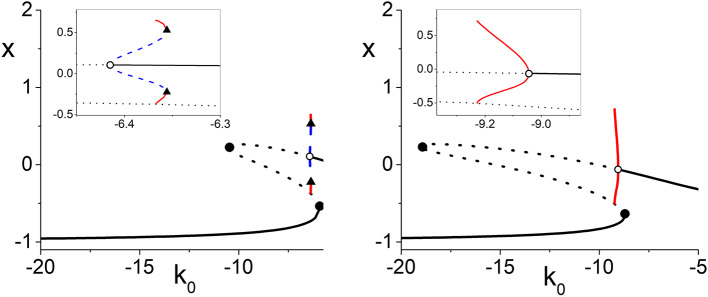
One-dimensional bifurcation diagrams showing x = Re(z) vs. k0 illustrating subcritical (left) and supercritical (right) Hopf bifurcations (open circles). The insets are magnifications. These diagrams correspond to paths along the black lines in the top left panel of Figure 7. Here, black solid (dotted) lines are stable (unstable) equilibria, red (dotted blue) lines indicate stable (unstable) limit cycles, solid circles are saddle-node bifurcations, and triangles are saddle-node-of-periodic-orbits bifurcations. The other parameters are Δk = 0.0, n = 2, Δη = 0.4, and η0 = 6.0 (left) and 11.0 (right).